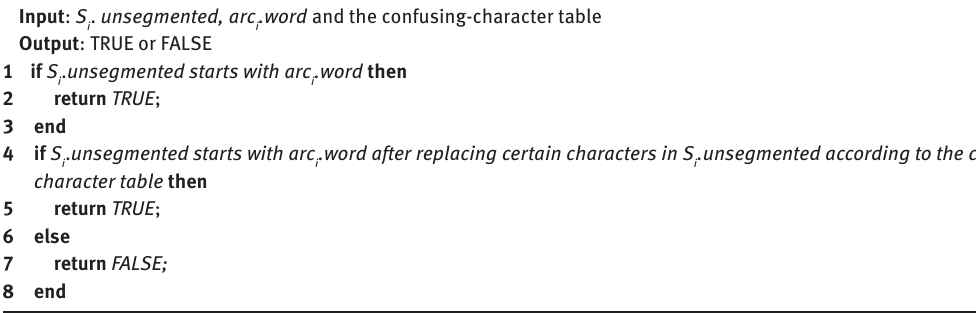
Algorithm 5: Judge Passable Forward Arcs in Modified